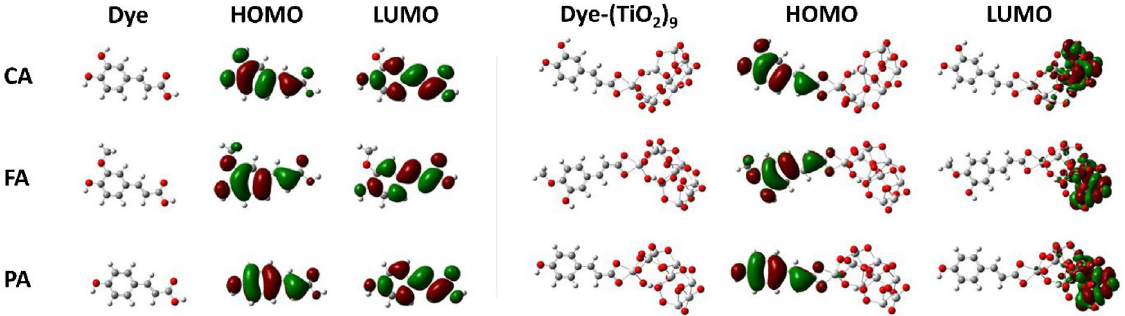
Figure 1. Optimized structures and frontier molecular orbitals (FMOs) of isolated dyes (CA, FA, PA) and dye- (TiO 2 ) 9